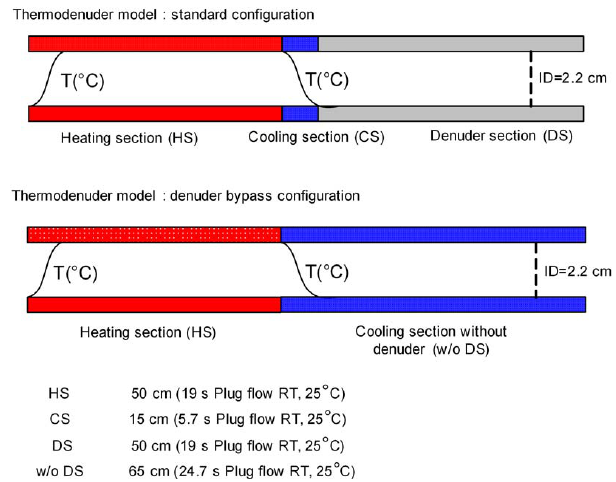
Fig. 1. Schematic of the thermodenuder design used for the calcu- lations. The configuration with denuder bypass was also calculated to explore the potential for re-condensation and the efficiency of the charcoal denuder. Air flow=0.6lpm, RT=residence